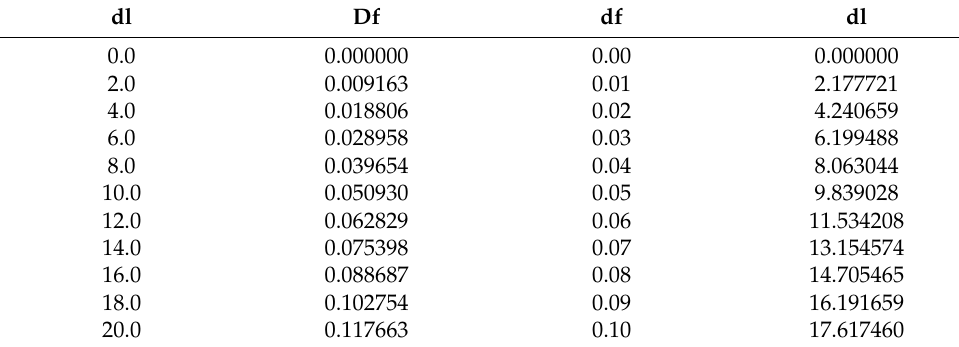
Figure 6. Locus of the second lens group of the focus-adjustable collimator. Table 1. Zoom locus of the focus-adjustable collimator.